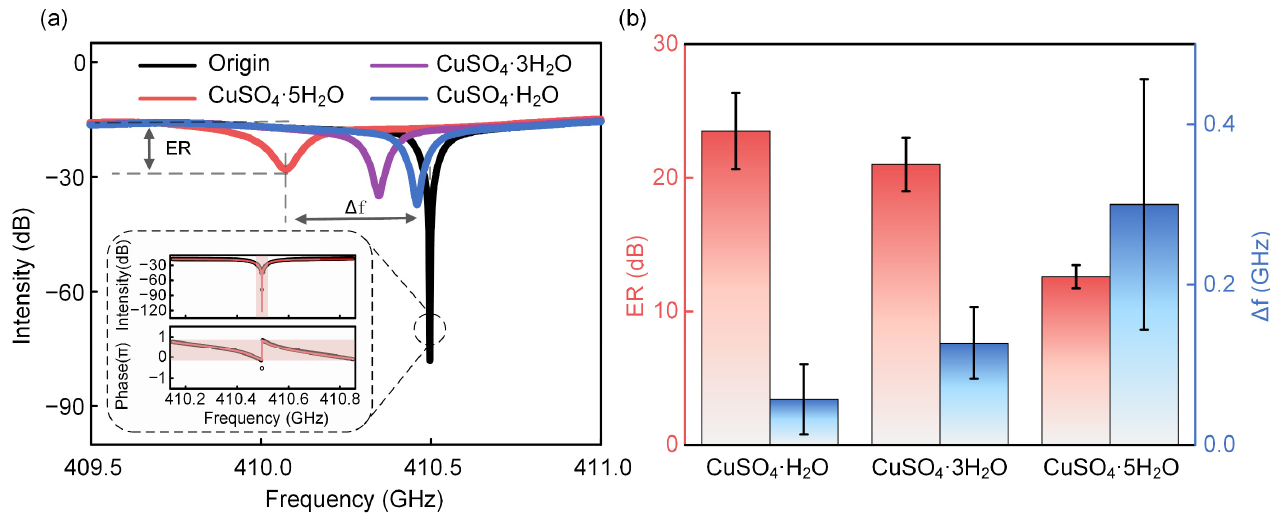
Figure 2. The spectra of the THz-WGMR and the experimental results for CuSO 4 · xH 2 O (x = 5, 3, 1). ( a ) The intensity spectra of the THz-WGMR covered with one dot of 1 μ mol CuSO 4 ·xH 2 O (x = 5, 3, 1). The insets are the intensity spectrum and phase profile of the THz-WGMR. The black circles and red lines in insets represent the experimental and analytical results, respectively. The intensity spectrum of the THz-WGMR illustrates the resonance frequency of 410.497 GHz and the quality (Q) value of 3305. The phase profile demonstrates a π shift, indicating the THz-WGMR works in the critical coupling state. ( b ) The extinction ratios (ERs) and frequency shifts of the resonance dip caused by one dot of 1 μ mol (0.5 μ L) CuSO 4 ·xH 2 O (x = 5, 3, 1).